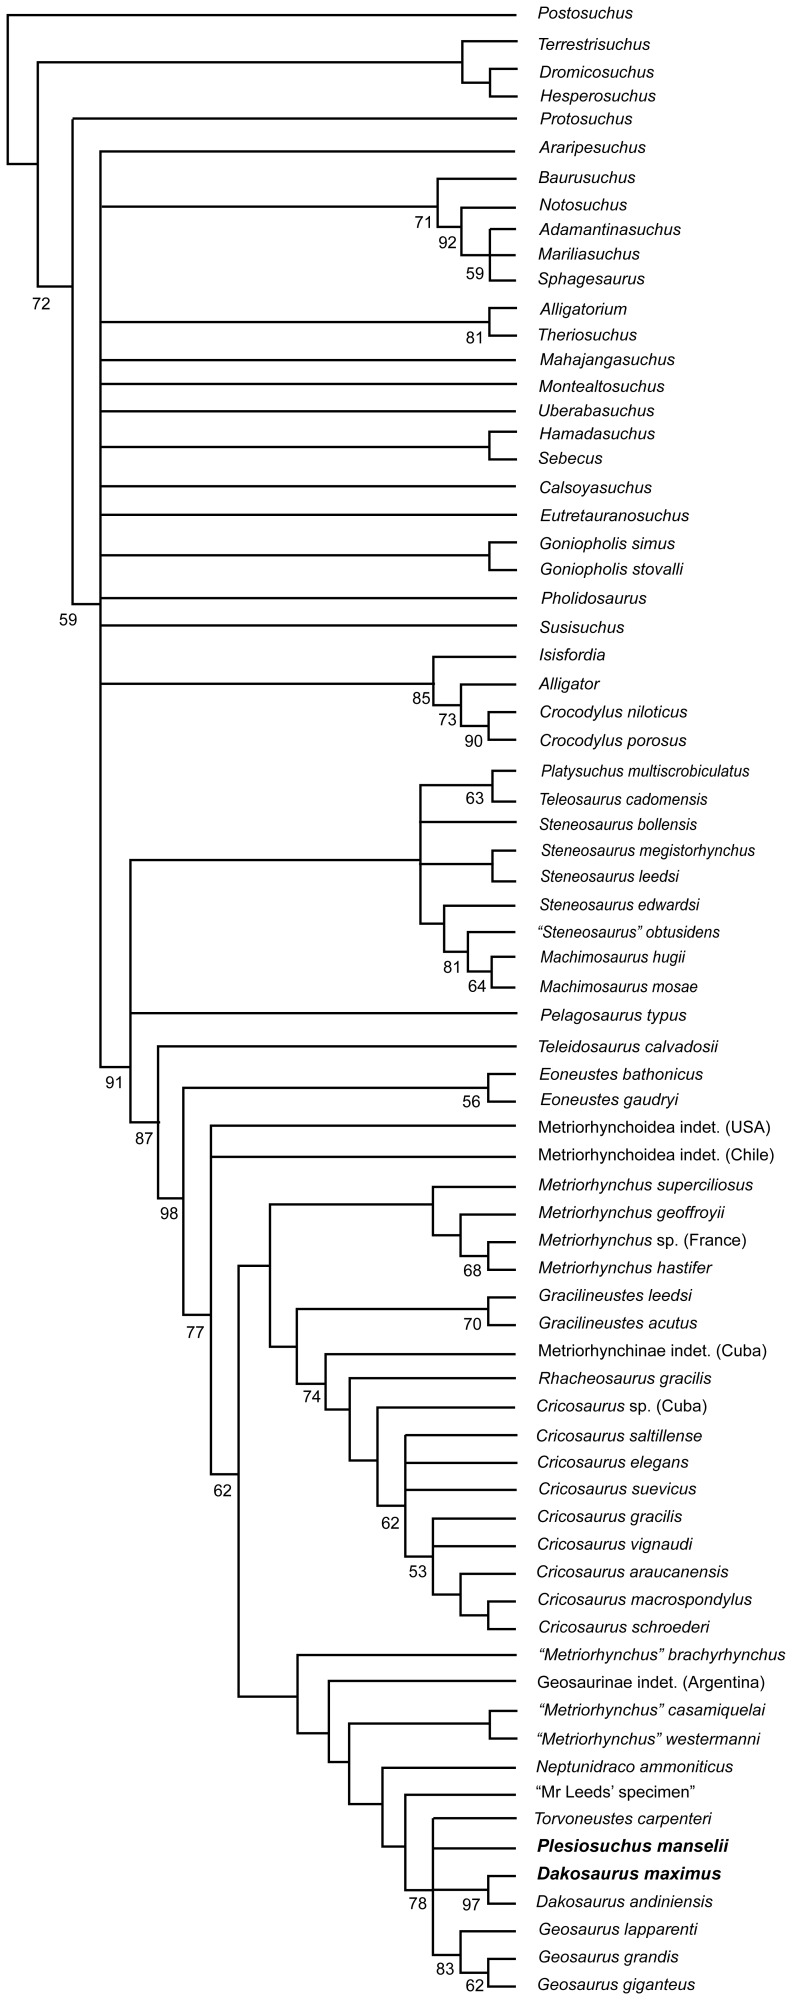
Strict consensus of 195 most parsimonious cladograms, showing the phylogenetic relationships of Plesiosuchus manselii and Dakosaurus maximus within Metriorhynchidae when 40 characters are ordered.Length = 667; ensemble consistency index, CI = 0. 481; ensemble retention index, RI = 0. 863; rescaled consistency index, RC = 0. 415. Bootstrap-values are given above or below the relevant node.